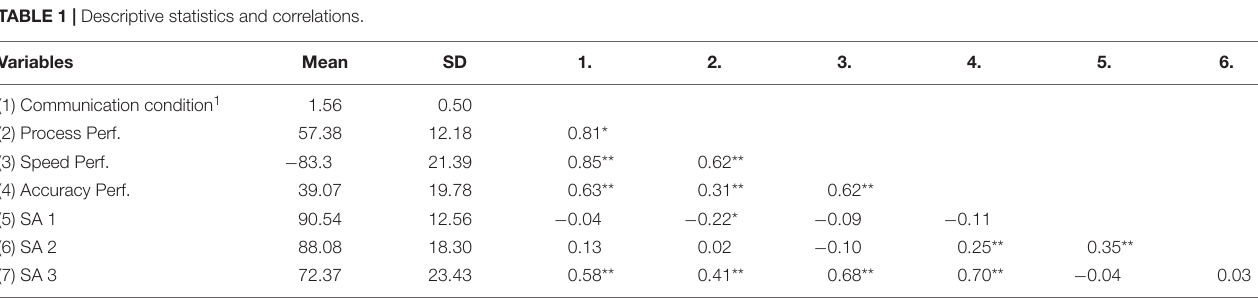
FIGURE 1 | The sharedness of situation awareness (SA) across SA levels and across team roles. The x-axis represents the roles in the integration team from 1 to 8 as presented on page 4: (1) The TST-cell Chief (CC) led the integration team; (2) the second in command (XO); (3) a senior intelligence duty officer that was responsible for integrate information from the intelligence surveillance and reconnaissance team (SIDO ISR); (4) a senior Operations Duty Officer (SODO tgt) that was responsible for targeteering and weaponeering (i.e., assigning weapons to specific targets); (5) a TST- CC Legal Adviser (Legad) providing the available judicial resources; (6) a battlefield coordination element/Special Operations liaison element (BCE/SOLE) that was responsible for input from the Land and Special Operations forces; (7) a role that was responsible for input from the maritime forces (MCE); and (8) a Communications Officer (COMMS). TABLE 1 | Descriptive statistics and